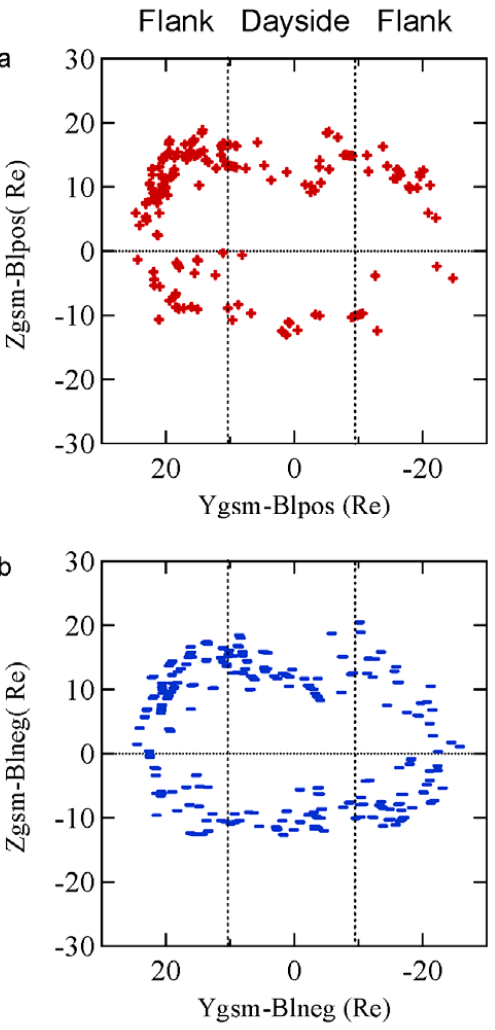
Fig. 7. Distribution patterns for FTEs occurring for (a) northward and (b) southward magnetosheath magnetic fields projected into the Y-Z plane.